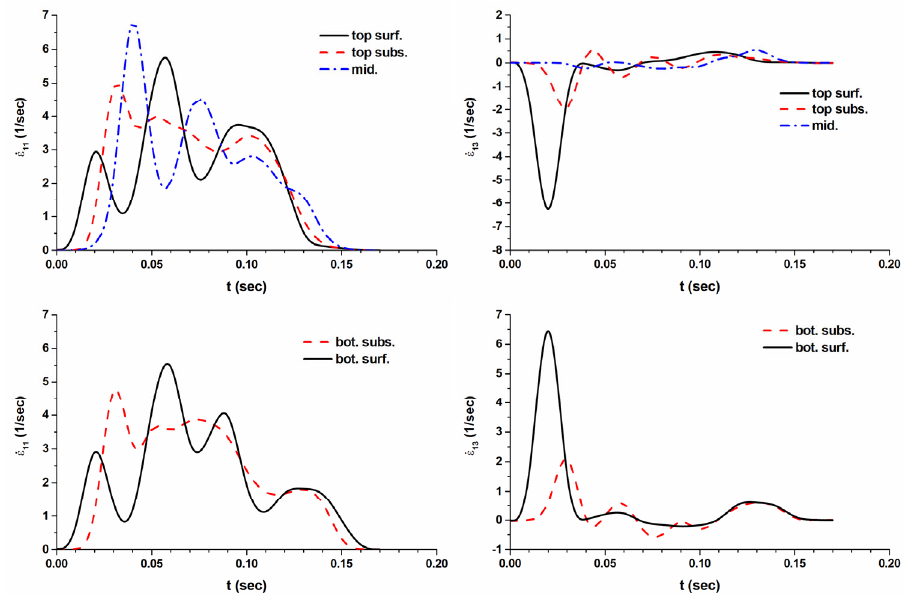
Figure 15. Strain rates in asymmetrically rolled sheet, calculated by FEM for different thickness layers: top and bot. surf.—are top and bottom surface layers; subsurf. layer is equidistant from both surface and middle; and mid. is the midthickness layer.